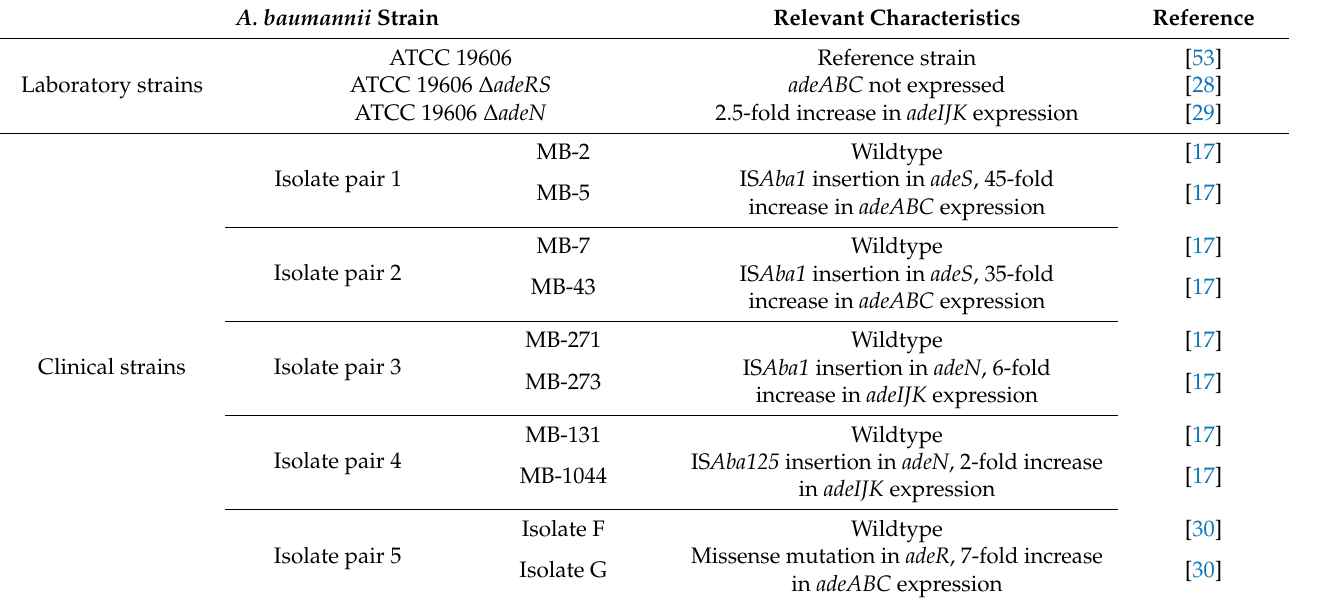
Table 2. Bacterial strains used in the current